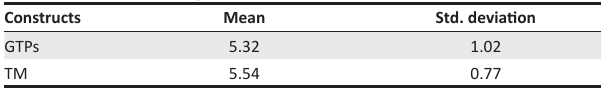
TABLE 3: Central tendency measure of two constructs.